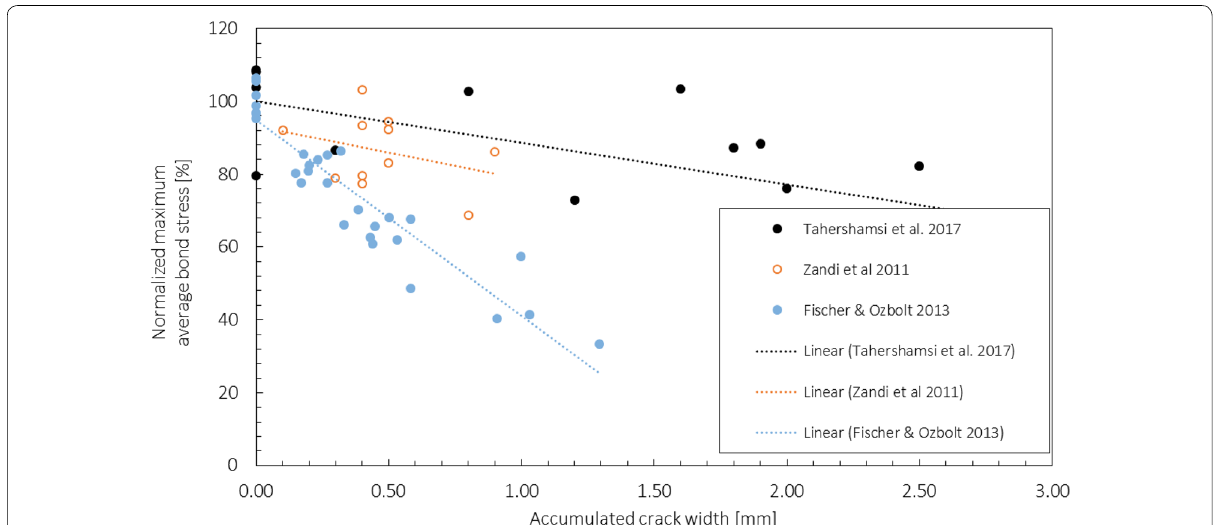
Fig. 5 Comparison between test results from naturally corroded specimens and results from artificially corroded tests in terms of bond strength, normalized with respect to the average maximum bond strength obtained from reference samples, versus maximum crack width of splitting